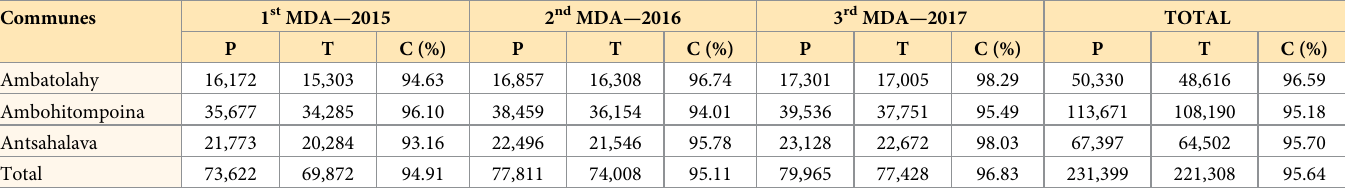
Table 1. Coverage of the 3-year MDA pilot project for taeniasis control in Madagascar.